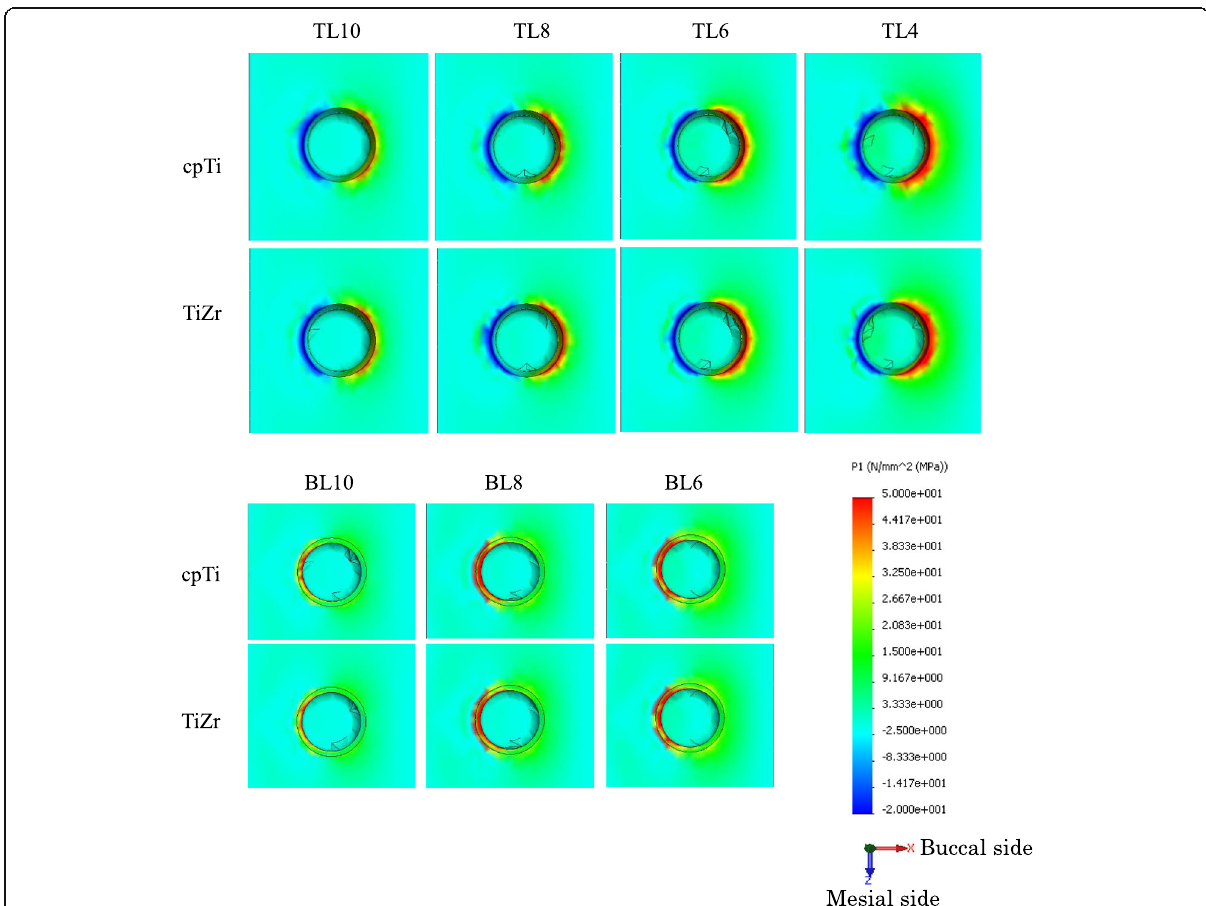
Fig. 5 Distribution of the maximum principle stress in the surrounding bone (occlusal view)